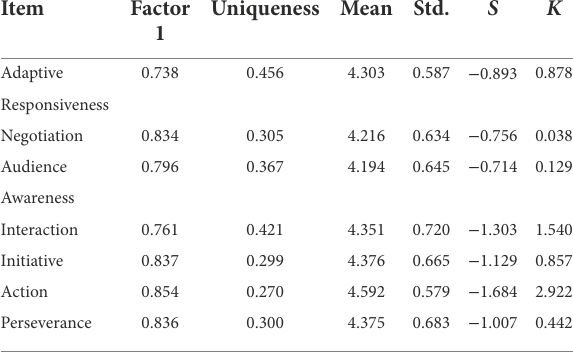
TABLE 6 SSC’s factor